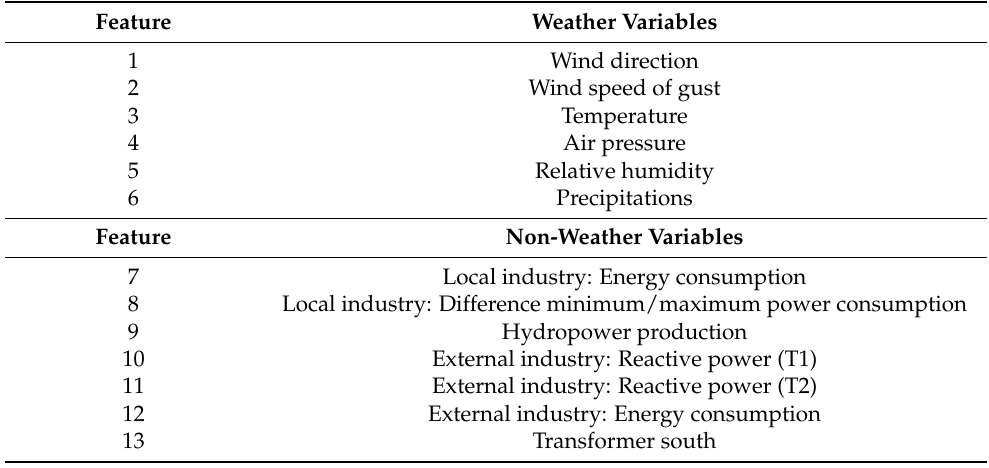
Table 2. Variables analyzed to detect failures in the SVAN22LY1 power